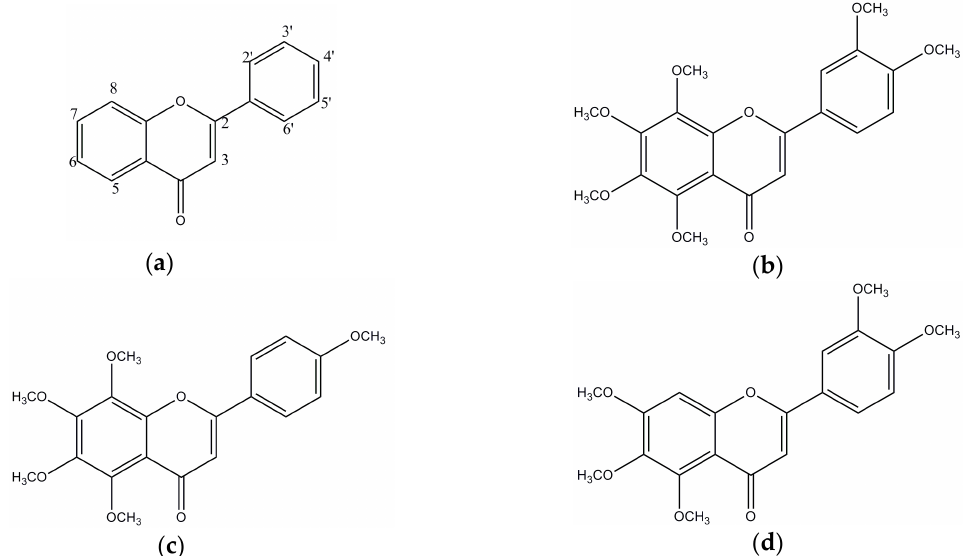
Figure 1. The chemical structures of polymethoxyflavones (PMFs): ( a ) flavone; ( b ) nobiletin; ( c ) tangeretin; ( d ) sinensetin.